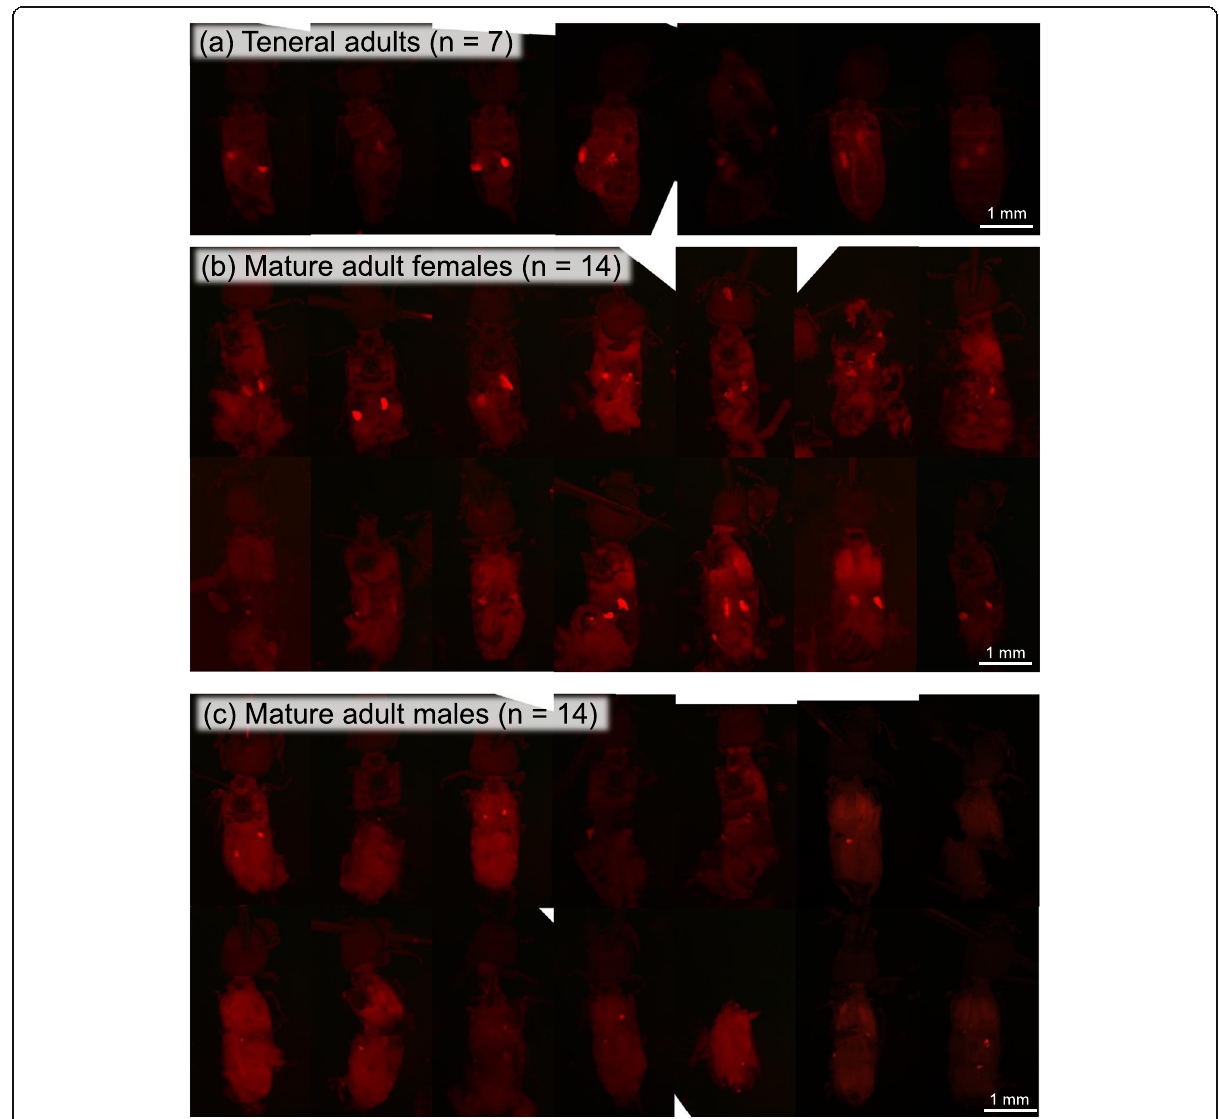
Fig. 7 Whole-mount fluorescence in situ hybridization of adult insects of R. dominica for visualizing size and location of the bacteriomes. a Teneral adults ( n = 7). b Mature adult females ( n = 14). c Mature adult males ( n = 14). Symbiont 16S rRNA is stained in red, highlighting the structure of the bacteriomes. All images are taken under an epifluorescence dissection microscope. Some images lack corners where the